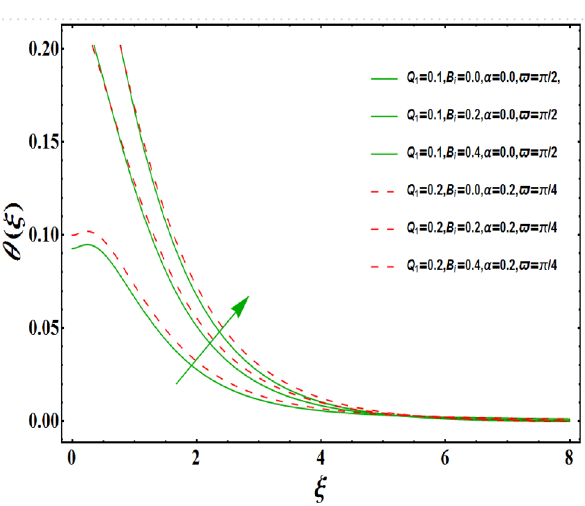
Figure 14. Variation of R 1 on θ(ξ) for both with and without inclanation.